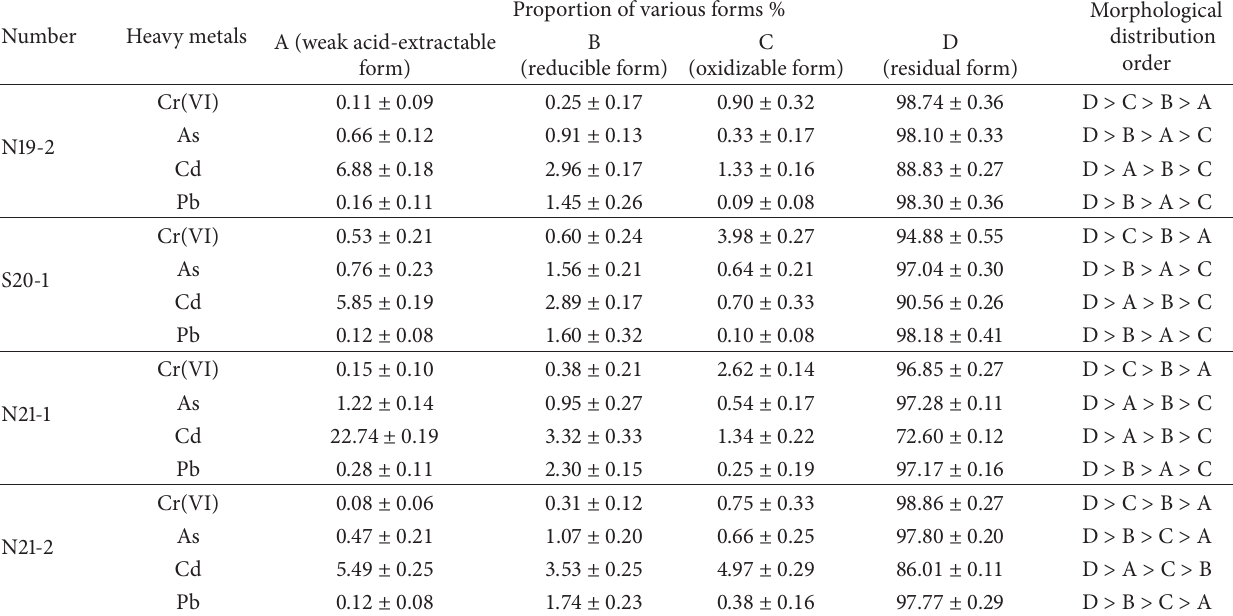
Table 8: Morphologic analysis of heavy metals in